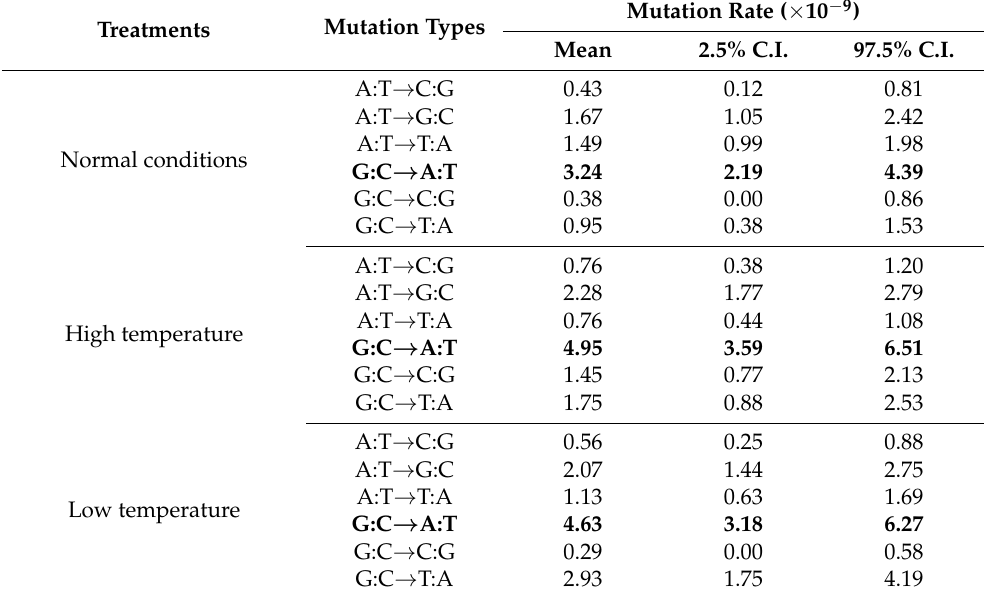
silkworm family, we calculated the callable sits and the mutation rate in intergenic and gene regions (combining exons and introns and including 5 (cid:48) - and 3 (cid:48) -UTRs) (Supplementary Table S6). We found that the mutation rate of the gene region is constant ( P = 0.76, Stu- dent’s t -test) in normal conditions and temperature stresses (Figure 4B). The mutation rates of the gene region in the normal condition and high-temperature- and low-temperature- treated families were 4.52 × 10 − 9 (95% CI = 3.23 × 10 − 9 –5.92 × 10 − 9 ), 4.95 × 10 − 9